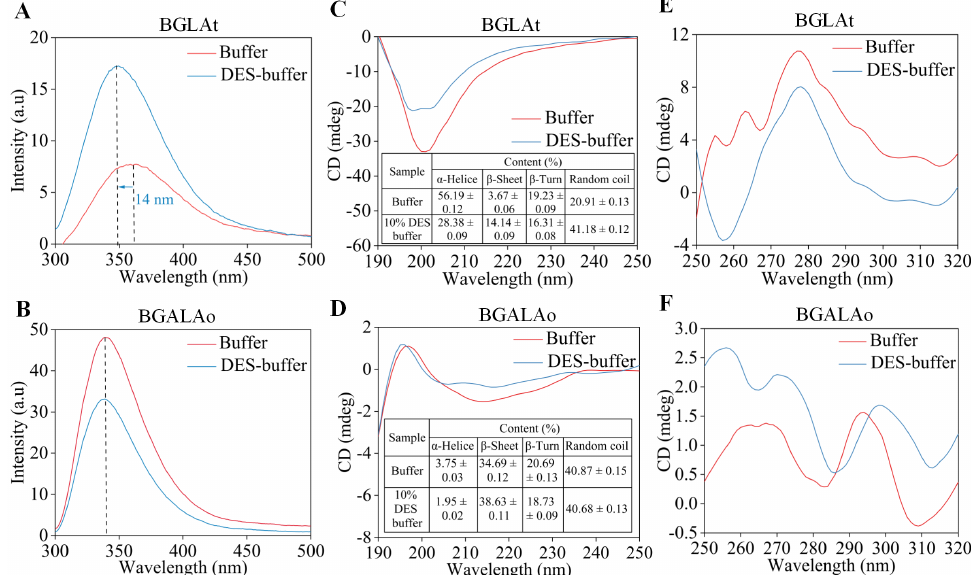
Figure 5. Spectra evaluating the impact of DES on the structure of the combinatorial enzymes (BGLAt and BGALAo). ( A ) Fluorescence spectra of BGLAt (0.5 μmol/L) in DES-buffer. ( B ) Fluorescence spectra of BGALAo (0.5 μmol·L − 1 ) in DES-buffer. ( C ) Far-UV CD spectra of BGLAt (0.02 g/L) in DES-buffer. D Far-UV CD spectra of BGALAo (0.02 g/L) in DES-buffer. The tables show the effects of DES-buffer on the secondary structure content (%) of BGLAt ( C ) and BGALAo ( D ). ( E ) Near-UV CD spectra of BGLAt (0.05 g/L) in DES-buffer. ( F ) Near-UV CD spectra of BGALAo (0.05 g/L) in DES-buffer. The samples of BGLAt and BGALAo are incubated in buffer as control, respectively ( A – F ). DES-buffer means that the buffer (citric acid buffer, 20 mM, pH 6.0) contains 10 wt % of DES (Bet: EG, 1:2) ( A – F